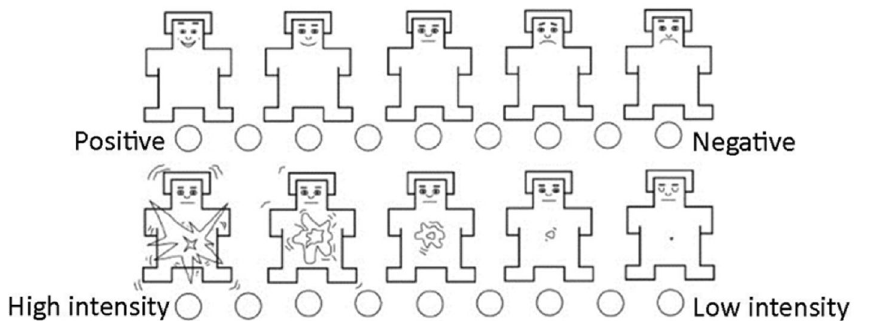
Figure 1. The adapted SAM (Bradley & Lang,